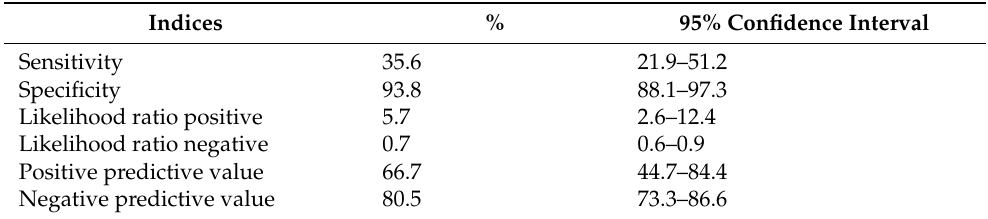
CMUI (cut point of high risk of failed reduction of more than 11 points; ≥